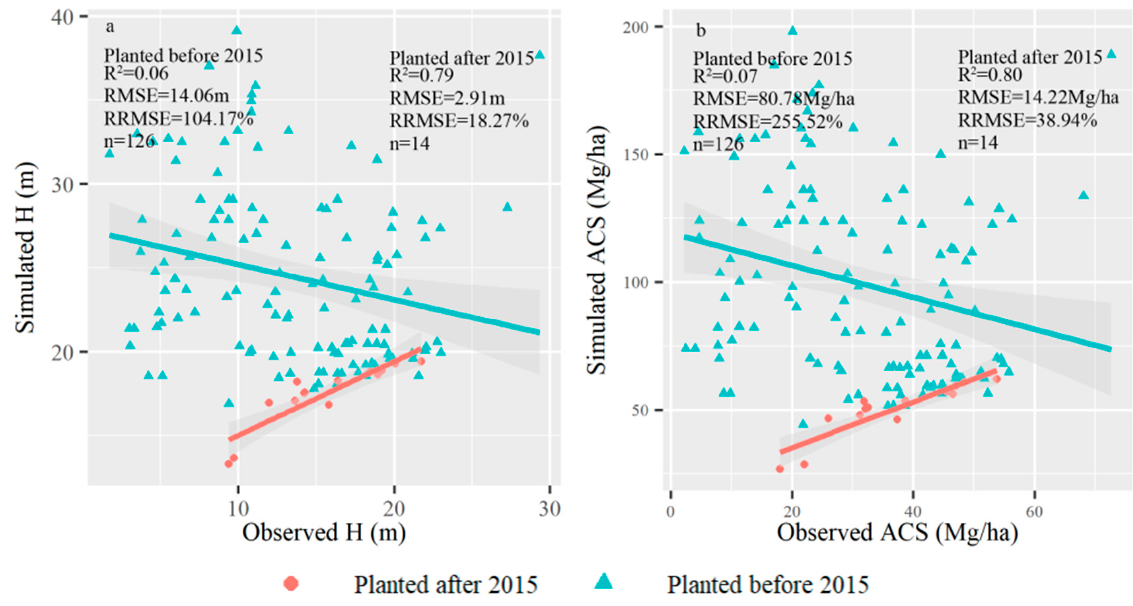
Figure 7. Validation of simulated height ( a ) and aboveground carbon stocks ( b ) based on FSC forest age data.